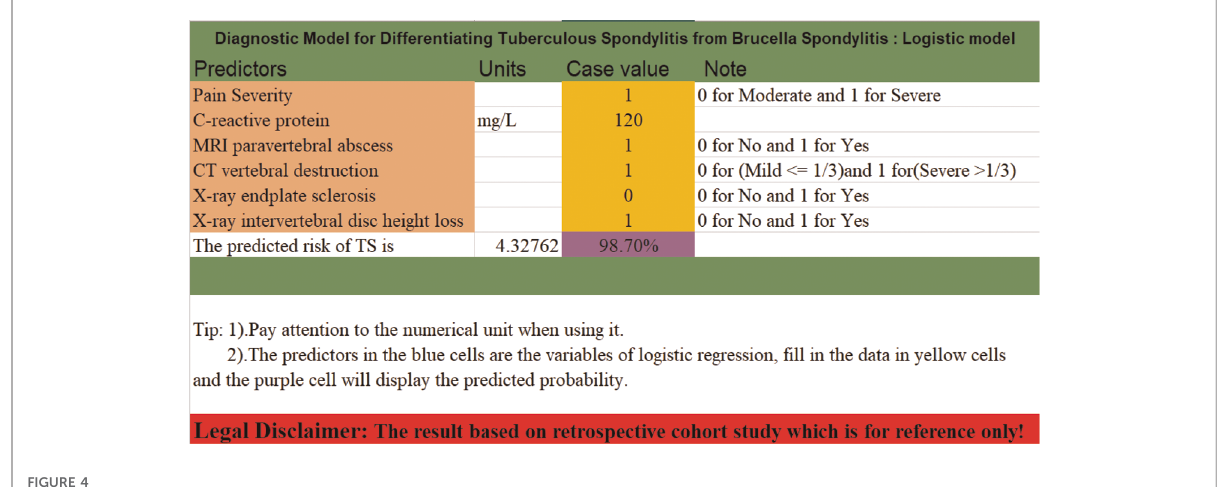
FIGURE 4 Selected models presented as logistic regression equations in this Excel (USA) document.